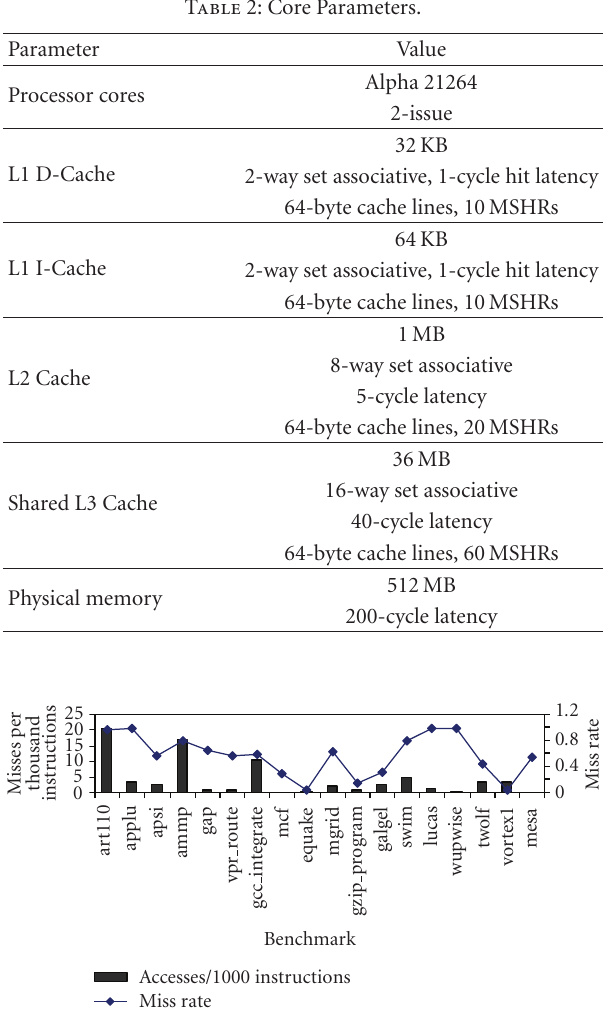
Figure 13: Miss rates and accesses per thousand instructions for considered SPEC